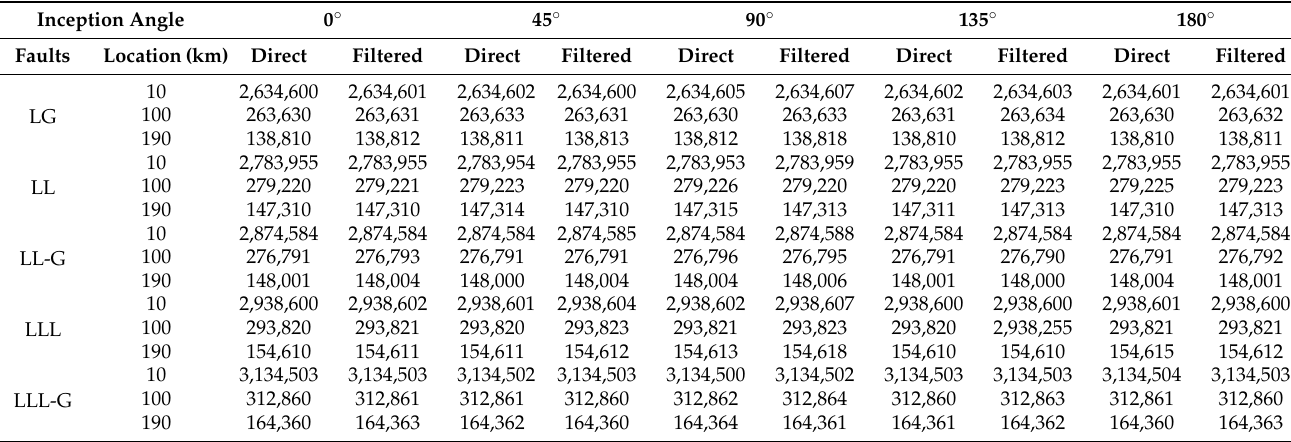
Table 3. Max singular values of FRFT-SVD results for direct and filtered current signals at various faults and inception angles with R = 10 Ω .